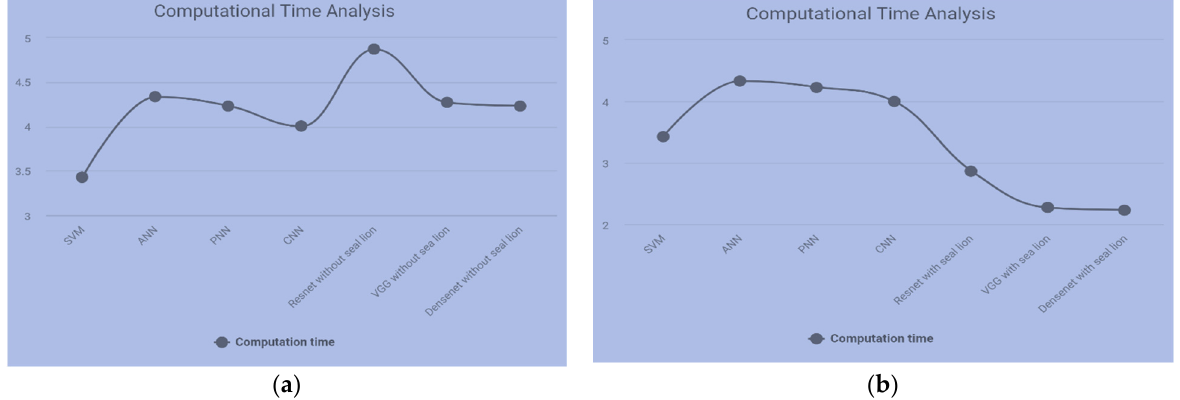
Figure 11. ( a ) Computation time without sea lion. ( b ) Computation time with sea lion.